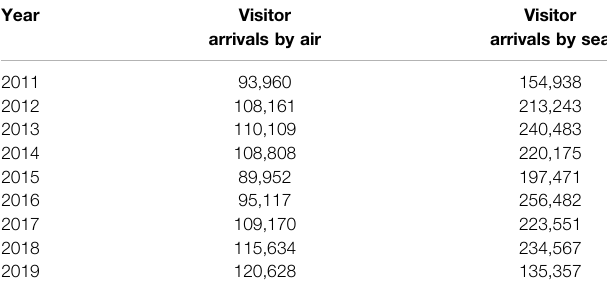
TABLE 2 | Visitor arrivals in Vanuatu 2011 – 2019. Source: Vanuatu Statistical Bureau,